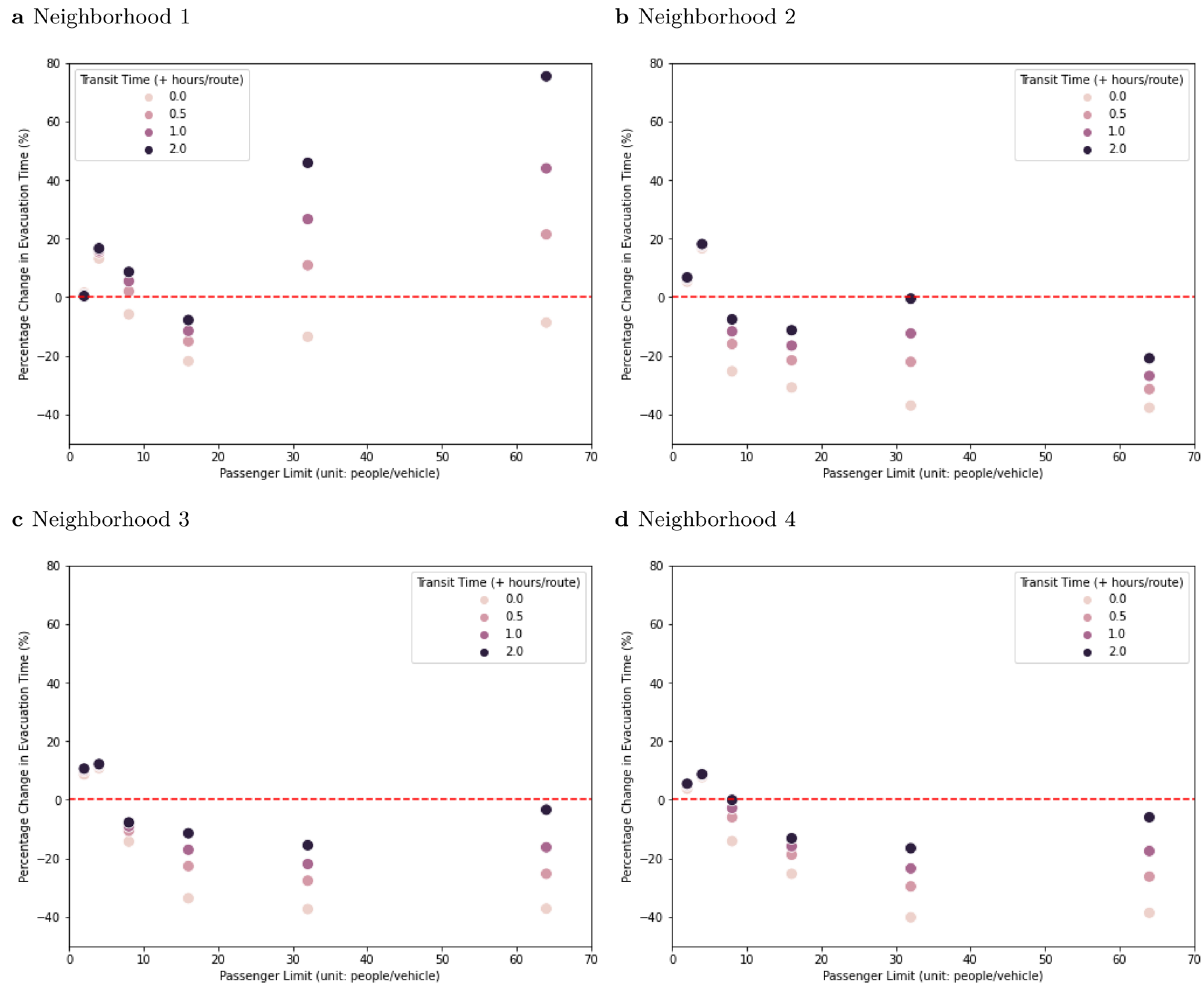
Figure 7. Performance comparison between DNN-based and non-DNN solutions in terms of total evacuation time for one neighborhood. The x-axis is vehicle capacity and the y-axis is the percentage change in evacuation time is calculated as Eq. (1). Points below the red dashed line indicate that the DNN-based solution saves time. ( a ) Neighborhood 1 has 52 people and 20 houses on the special needs registry. ( b ) Neighborhood 2 has 83 people and 35 houses. ( c ) Neighborhood 3 has 126 people and 52 houses. ( d ) Neighborhood 4 has 168 people and 68